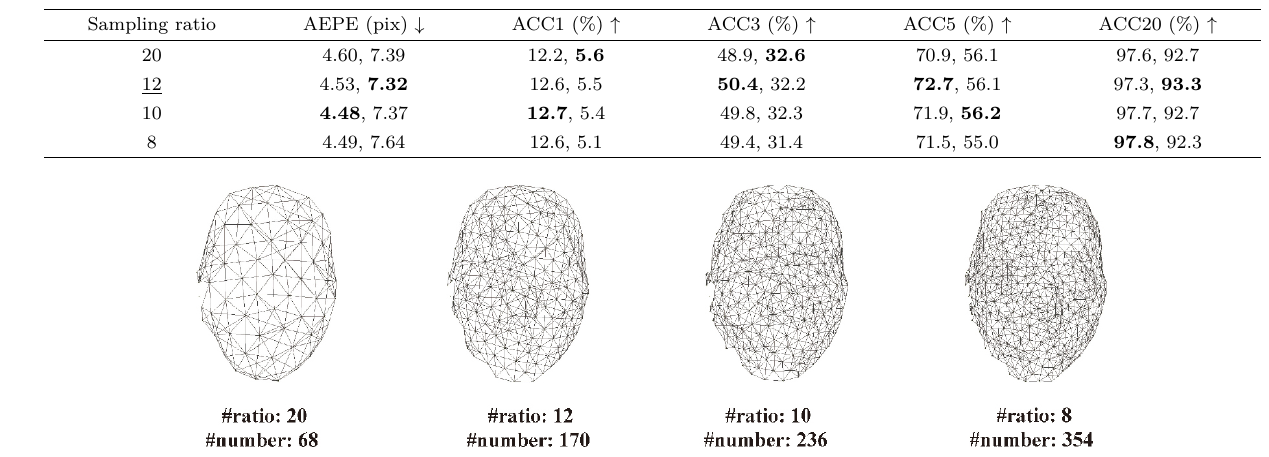
Fig. 5 Example deformation graph with different sampling ratio.